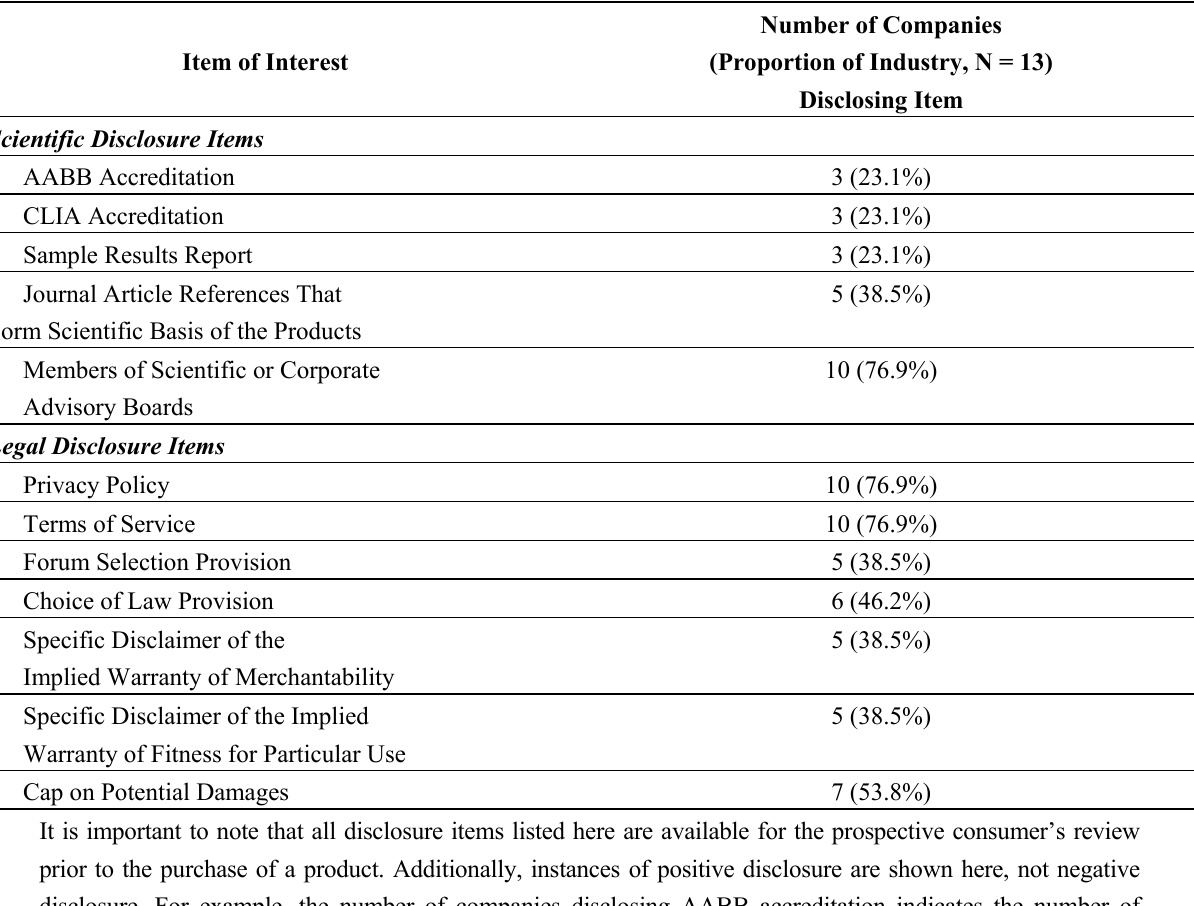
Table 4. Scientific and legal